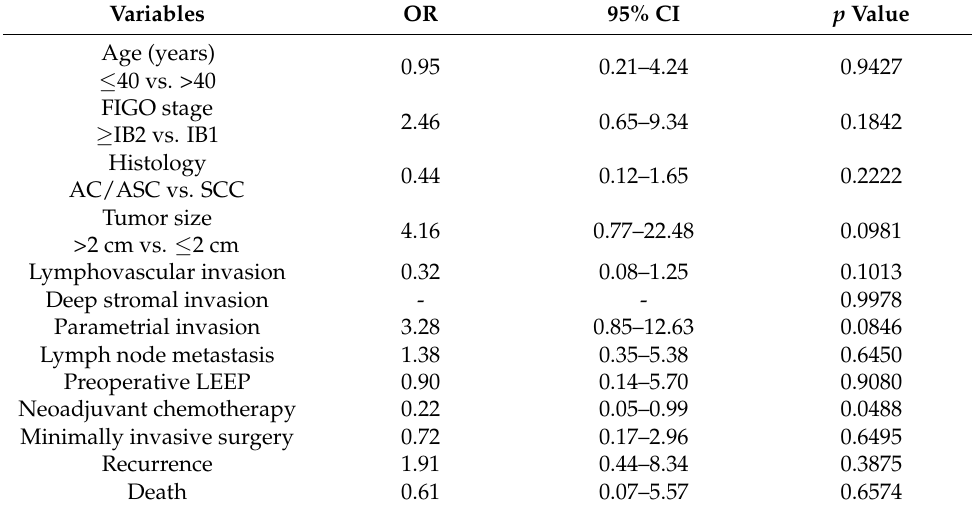
Table 4. Clinicopathologic variables associated with positive residual cancer